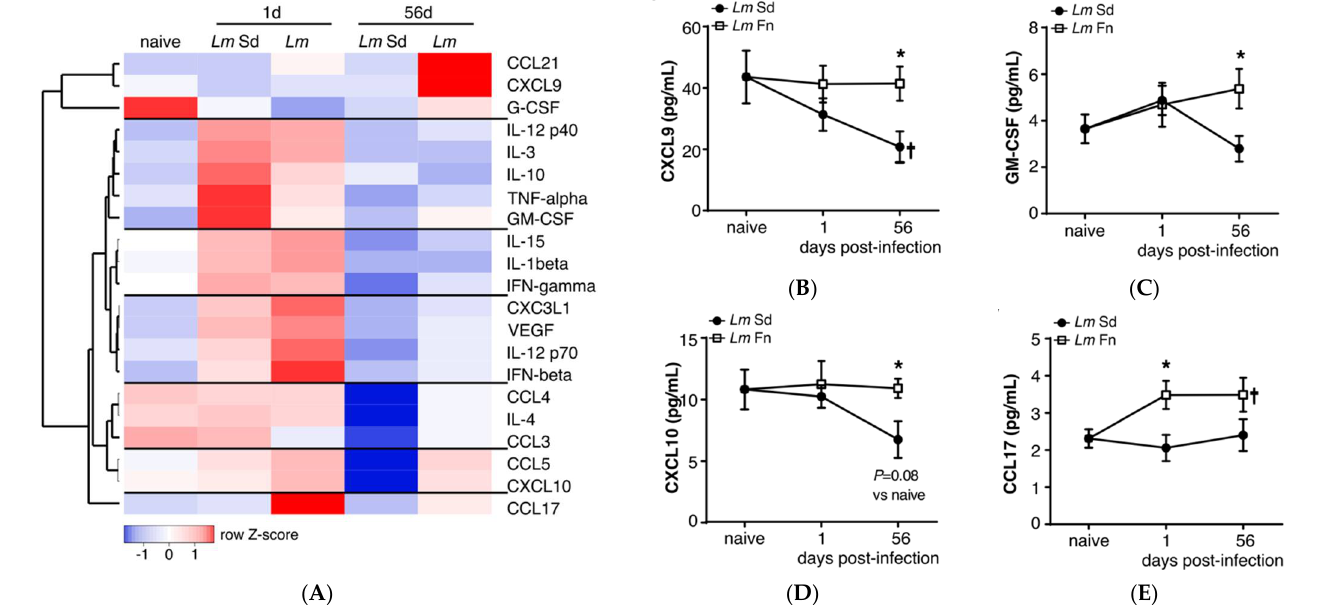
Figure 6. Bone marrow inflammatory cytokine/chemokine profiles indicate early activation and subsequent suppression of inflammatory responses in non-healing L. major infection: ( A ) Soluble cytokine/chemokine levels in bone marrow extracellular milieu after Lm Fn and Lm Sd infection. Heatmap represents relative quantities for each cytokine/chemokine as fold change compared to paired, sex-matched naive mice, and normalized across each row. Each square represents the average fold change for a sample of 4 males and 4 females mice per group. The raw concentration of ( B ) CXCL-9 (MIG); ( C ) Granulocyte-macrophage colony-stimulating factor (GM-CSF); ( D ) CXCL-10 (IP-10); and ( E ) CCL-17 (TARC) in bone marrow supernatant obtained from naïve and infected mice at 1- and 56-days post-infection. Graphs represent the mean ± SEM. * p < 0.05 comparing infection with Lm Fn vs. Lm Sd at a given time point and † p <0.05 comparing infected groups ( Lm Fn or Lm Sd) to naïve control mice.